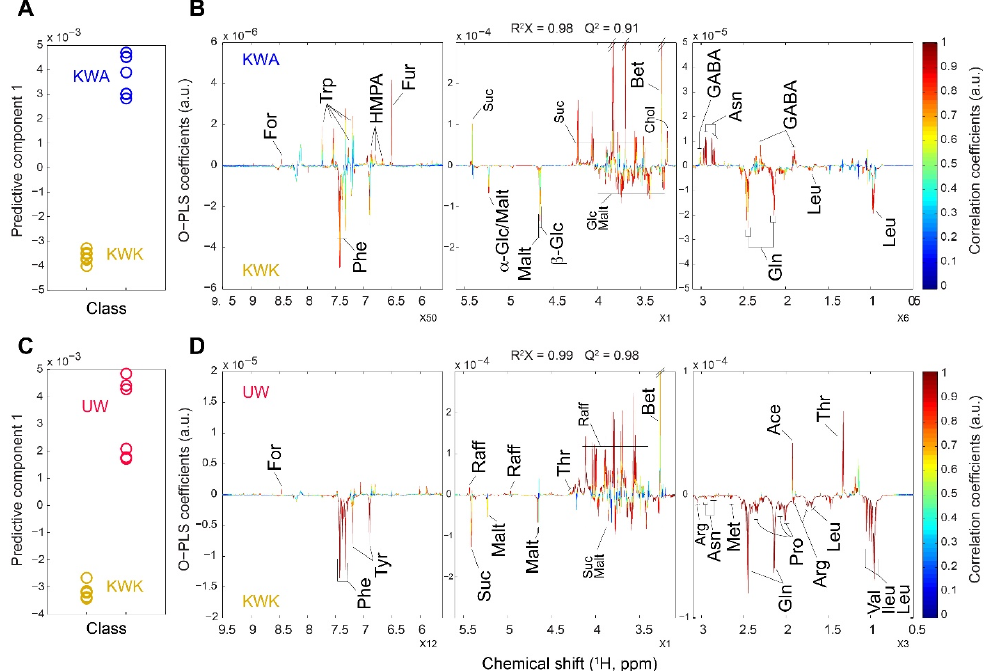
Figure 4. Orthogonal projections to latent structures-discriminant analysis (OPLS-DA) score ( A and C ) and loading ( B and D ) plots generated from 1 H NMR spectra of wheat malt extracts with a pairwise plot for metabolic comparisons between KWK and KWA ( A and B ) and between KWK and UW ( C and D ). GW: German wheat malt, UW: US wheat malt, KWA: Korean wheat malt (var. Anzunbaengi ), KWJ: Korean wheat malt (var. Jokyung ), KWK: Korean wheat malt (var. Keumkang